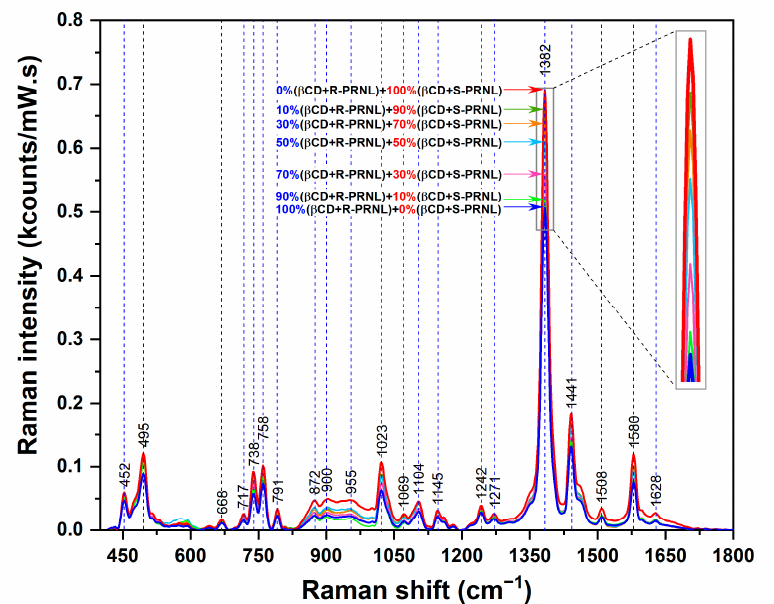
Figure 5. SERS spectra of pure R– β CDs (blue curve) complexes, S– β CDs (red curve) complexes and of mixed solutions containing different ratios of R/S– β CDs complexes (green, magenta, light blue, orange, and olive curves). The spectra were collected by using a 785 nm wavelength on the same plasmonic substrate. The inset highlights the intensity of the 1382 cm − 1